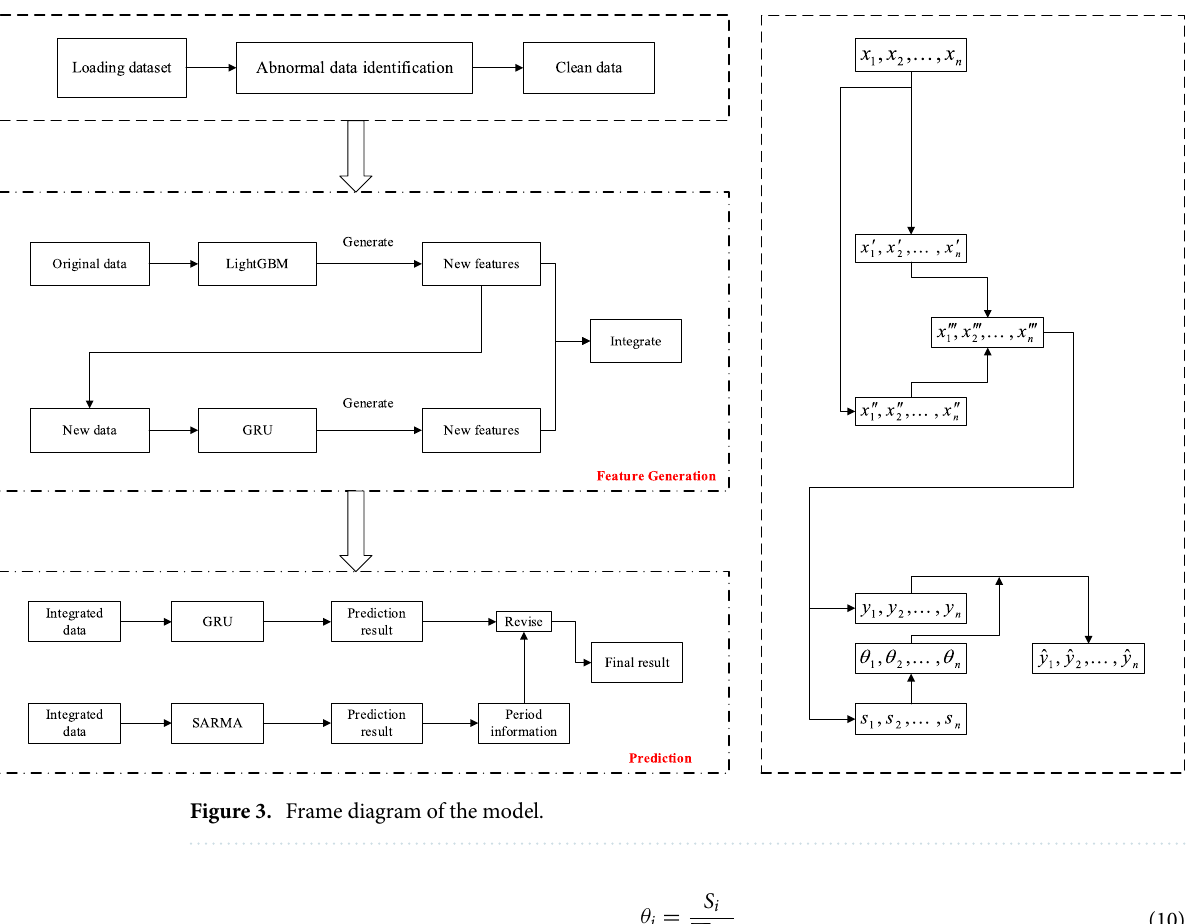
Figure 3. Frame diagram of the